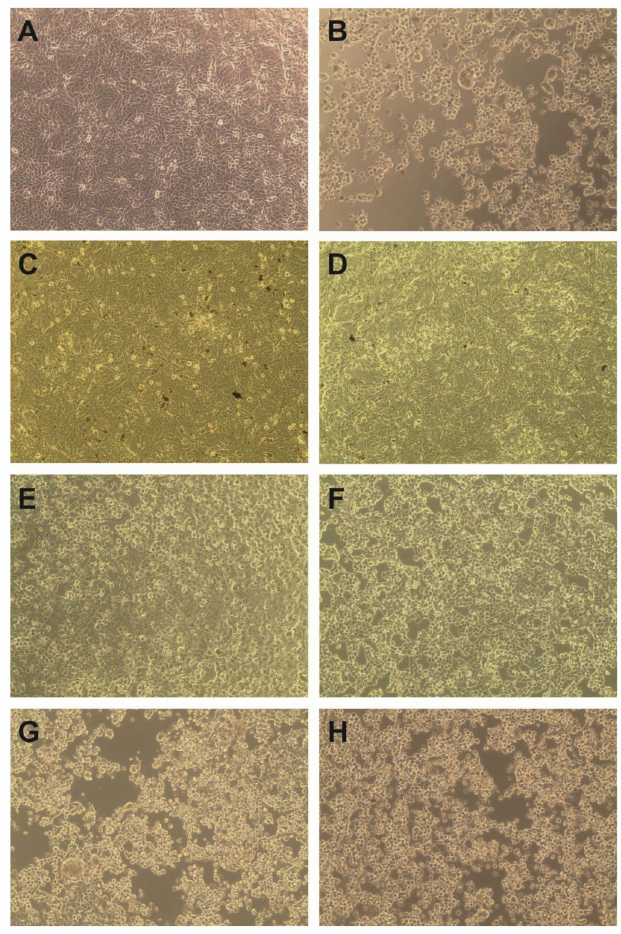
Figure 5. Influence of S. campanulata on the HHV-1-induced cytopathic effect (magnification × 100). ( A )—VERO cell control; ( B )—HHV-1 induced cytopathic effect (CPE) in infected VERO cells; HHV-1 infected VERO cells treated with ScLM 500 µ g/mL ( C ), ScLM 250 µ g/mL ( D ), ScSbM 500 µ g/mL ( E ),